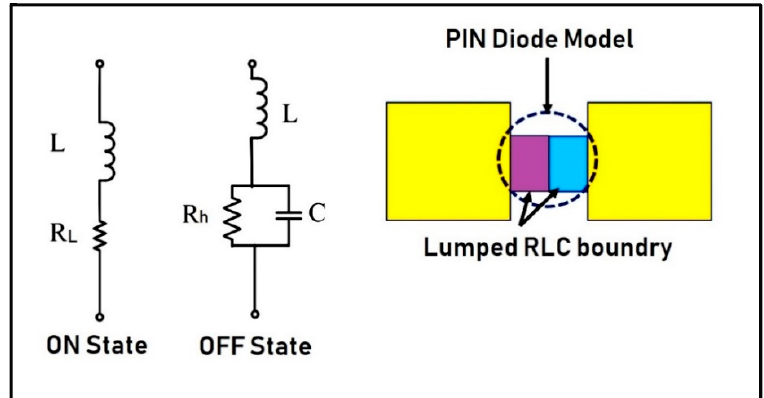
Figure 3. PIN diode model and its Equivalent circuits for ON and OFF states.